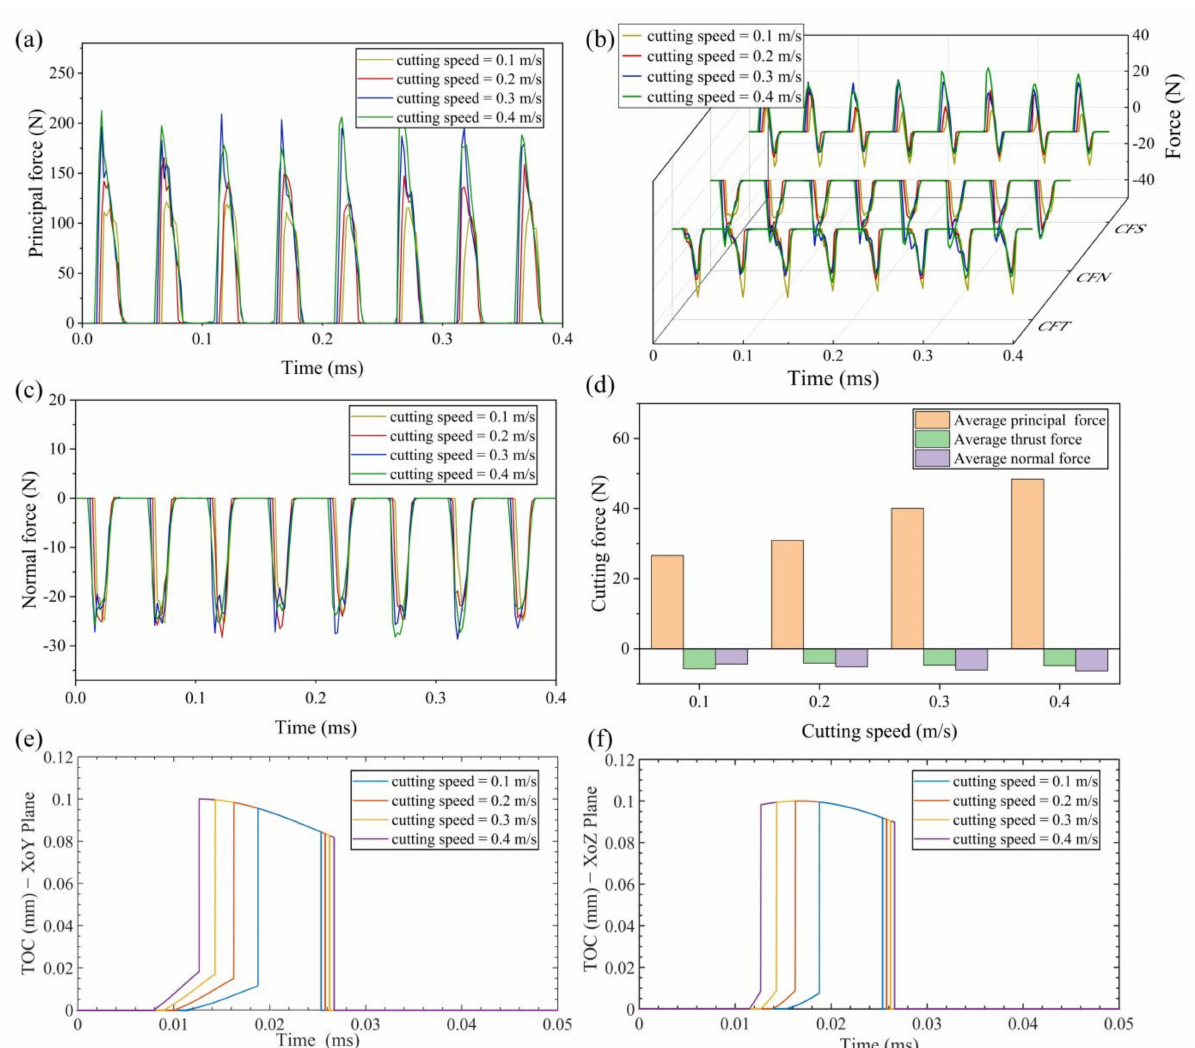
Figure 5. Results of cutting force and TOC with various cutting speeds ( a ) principal force ( b ) thrust force ( c ) normal force ( d ) average cutting force ( e ) TOC with various cutting speeds in XoY plane ( f ) TOC with various cutting speeds in XoZ